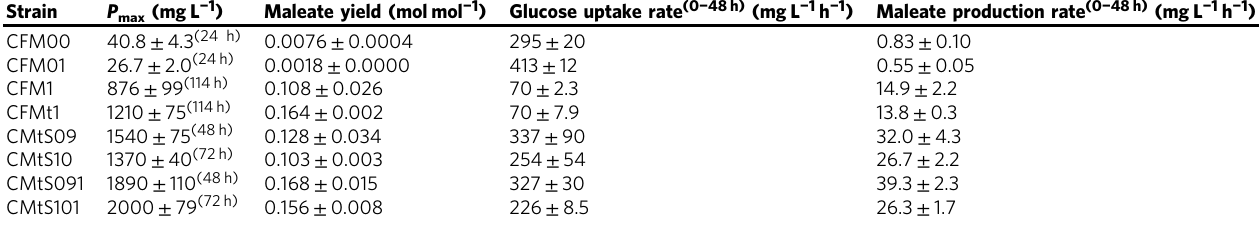
Table 1 Summary of maleate production by each engineered E. coli strain Strain